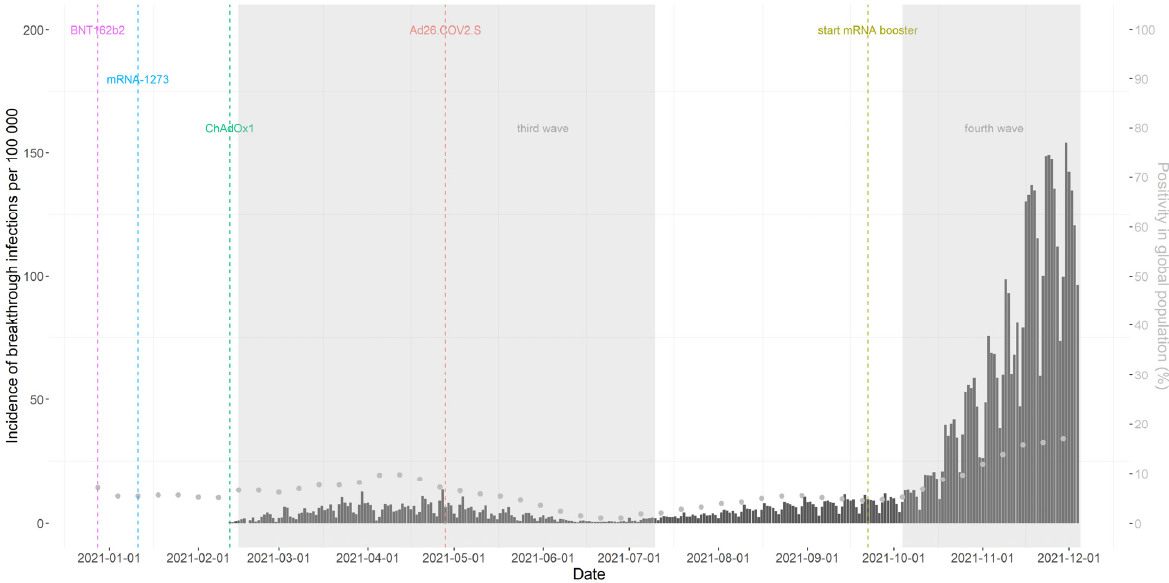
Figure 2. Daily incidence of breakthrough infections per 100,000 persons during 2021 among fully vaccinated persons (bars) and the weekly positivity rate in the global population (dots). Dashed lines represent the introduction of different primary vaccine brands or of the mRNA booster. Shaded areas represent the occurrence of waves of COVID-19 infections in Belgium.